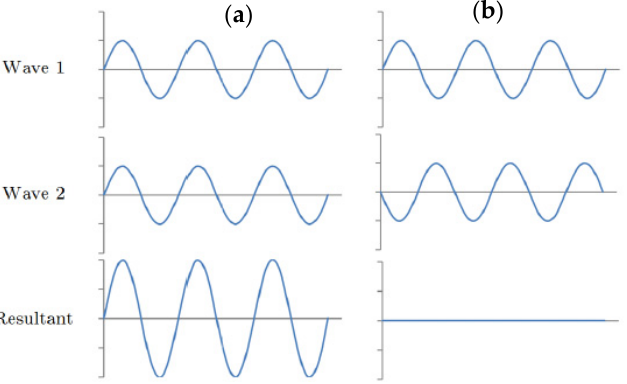
Figure 6. Superposition of waves showing ( a ) constructive interference and ( b ) destructive interfer-